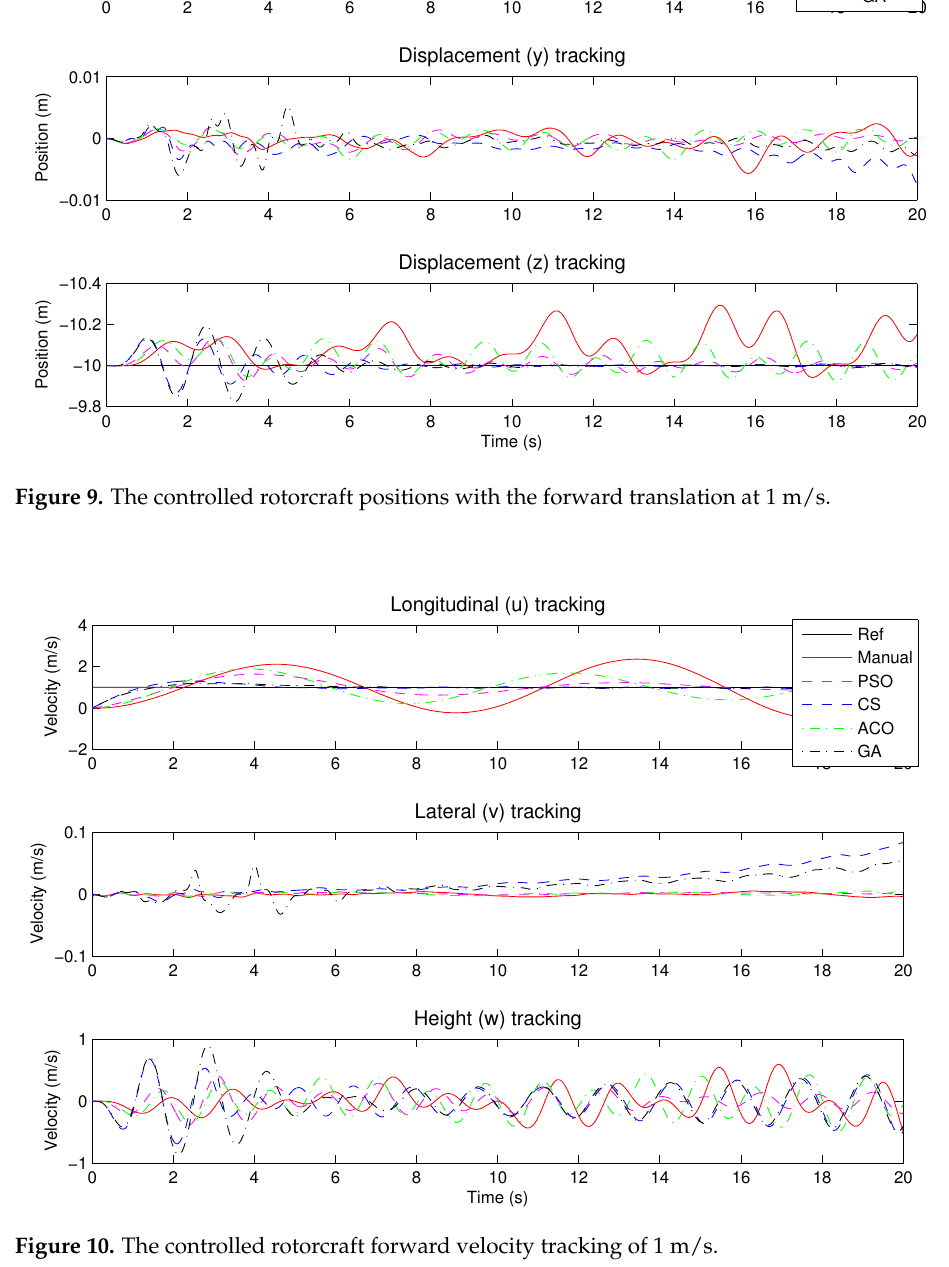
Figure 10. The controlled rotorcraft forward velocity tracking of 1